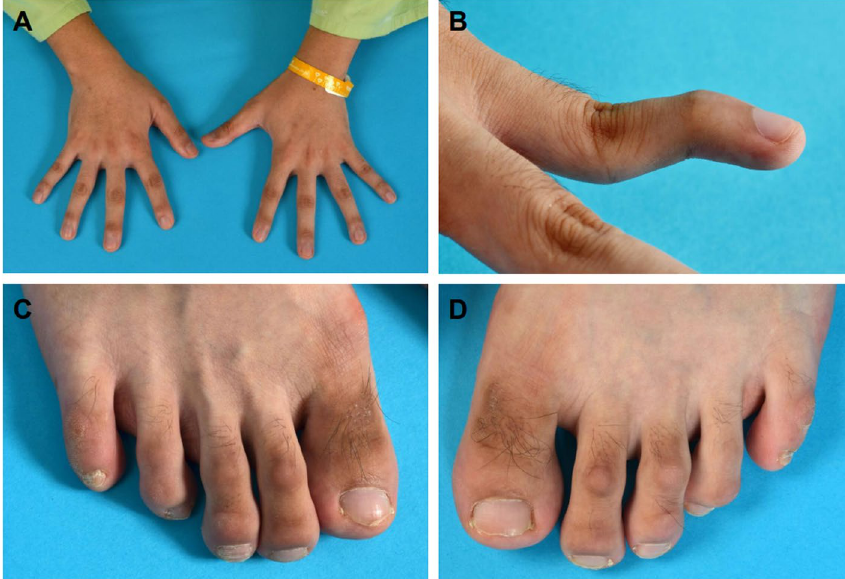
Figure 2. Skeletal findings of the patient. The hands showed brachydactyly ( A ) and angulation of the 5th fingers ( B ). Broad halluces and hypertrichosis were observed in the toes ( C , D ).